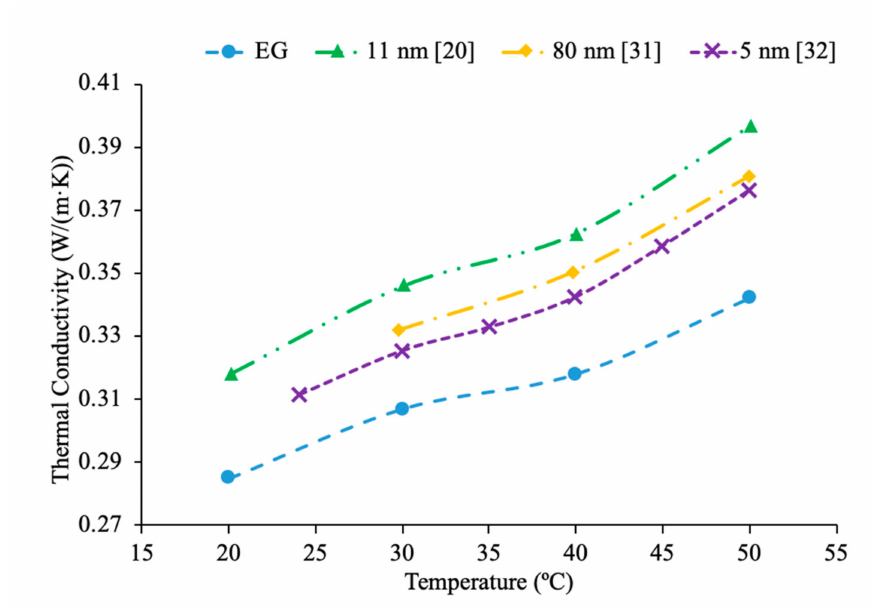
Figure 6. Thermal conductivity of Al 2 O 3 –ethylene glycol (EG) nanofluids as a function of temperature at a volume fraction of 1% with nanoparticle diameters of 5, 11 and 80 nm [20,31,32].